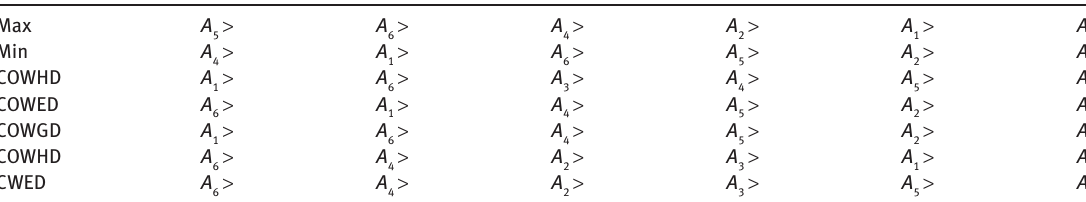
Table 8: Ordering of the Strategies.